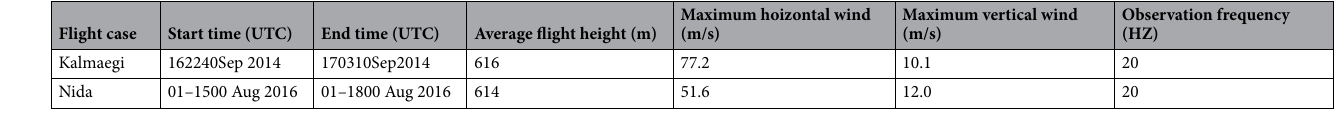
Table 1. Flight observation information of the typhoon cases.